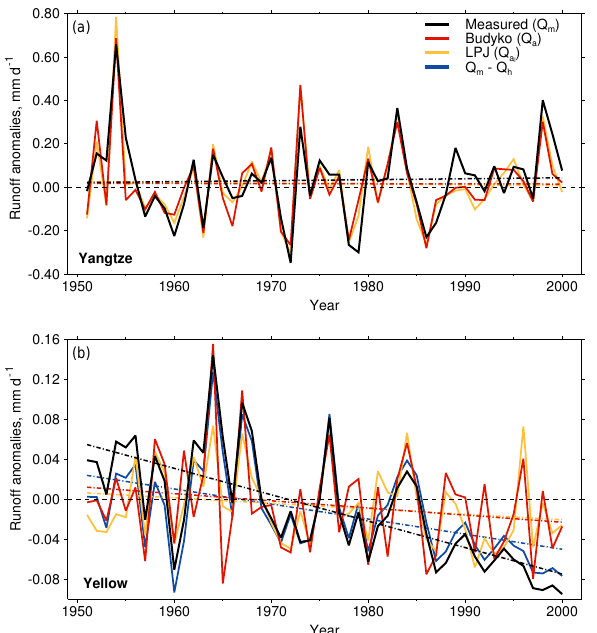
Figure 6. Runoff anomalies for the Yangtze (a) and Yellow (b) River catchments for 1951–2000, relative to 1961–1990. Shown are measured runoff ( Q m ), runoff due to aridity change ( Q a ), runoff simulated by the LPJ LSM ( Q a ), and (for the Yellow River only) l the difference between Q m and runoff due to direct human im- pacts ( Q h ). The dashed lines show linear fits to the time